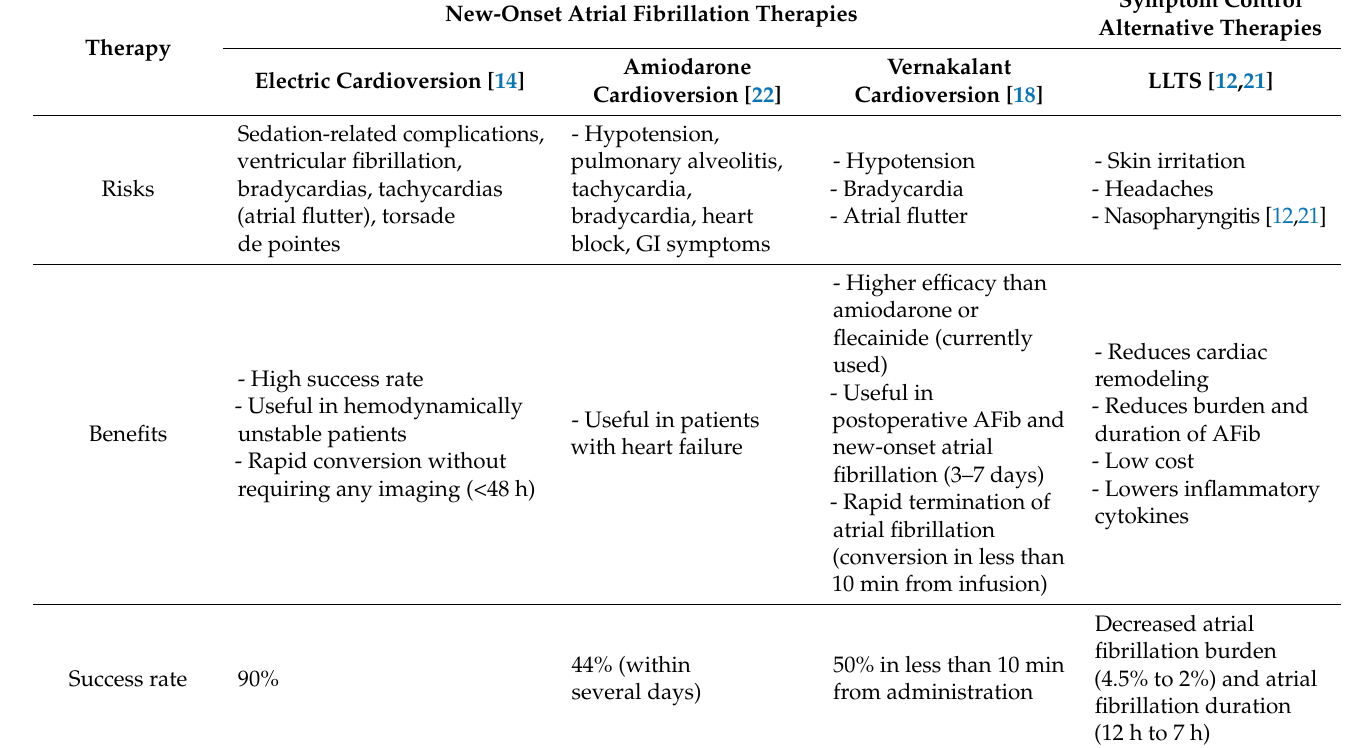
Table 4. Risks and benefits for new-onset atrial fibrillation and symptom control